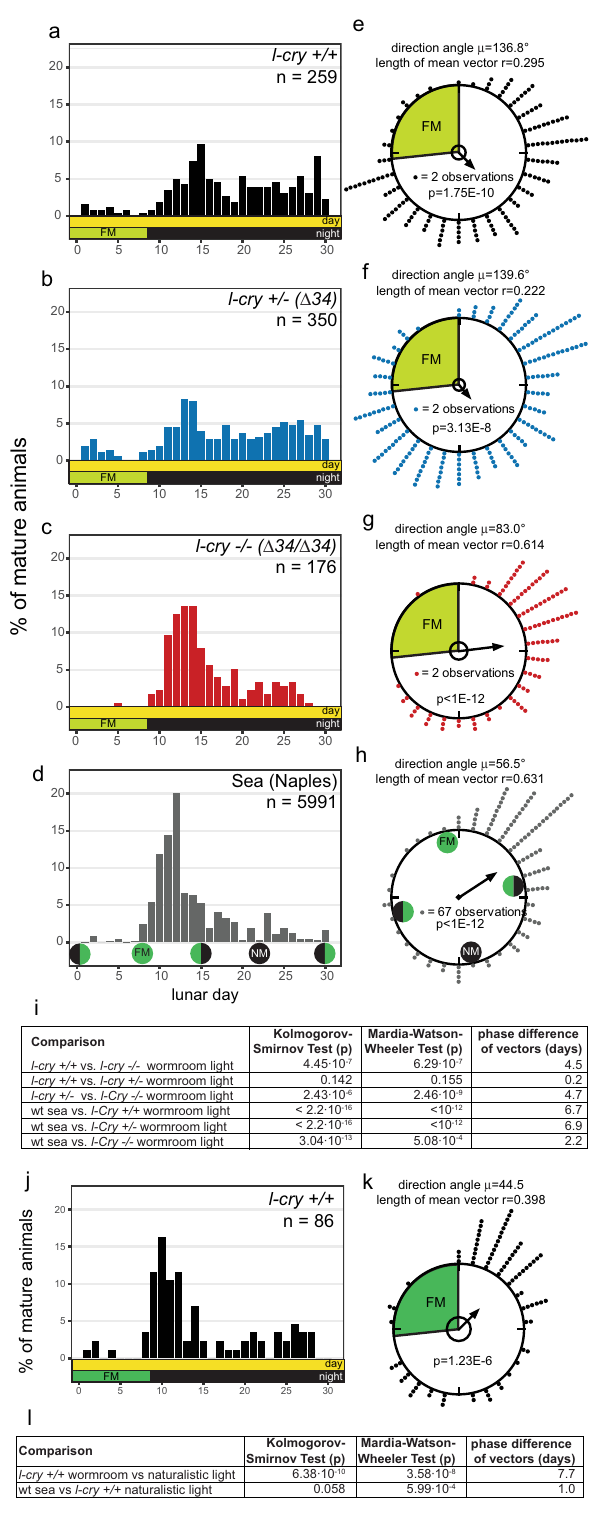
Fig. 2 | L-Cry shields the circalunar clock from light that is not naturalistic moonlight. a – d, j Spawning of l-cry +/+ ( a ), l-cry +/ – ( Δ 34) ( b ) and l-cry − / − ( Δ 34/ Δ 34) ( c ) animals over the lunar month in the lab with 8 nights of arti fi cial moonlight ( a – c ), under natural conditions in the sea ( d , replotted from ref. 34,50,) and in the lab using naturalistic sun- and moonlight (j, 8 nights moonlight). e – h , k Data as in ( a – d , j ) as circular plot. 360° correspond to 30 days of the lunarmonth. The arrow represents the meanvector,characterized by the directionangle µ and r (length of µ ).rindicatesphasecoherence(measureofpopulationsynchrony). p -values inside the plots: result of Rayleigh Tests. Signi fi cance indicates non-random distribution of data points. The inner circle represents the Rayleigh critical value ( p =0.05). i – l Results of two-sided multisample statistics on spawning data shown in ( a – h , j , k ).The phase differencesindays canbecalculatedfrom the anglebetween the two mean vectors (i.e. 12°= 1